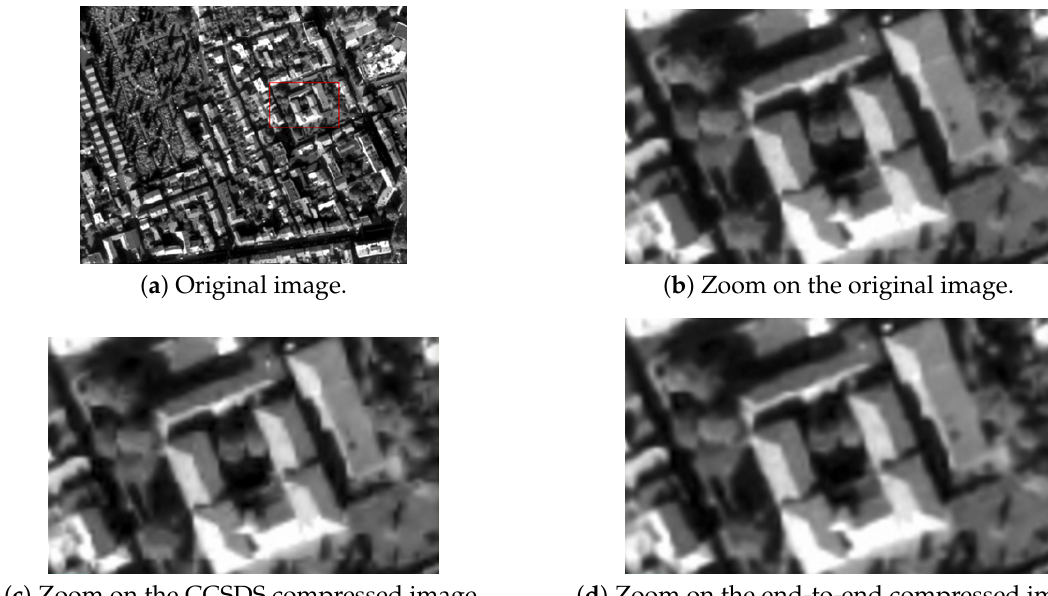
Figure 8. Subjective image quality analysis (R = 1.66